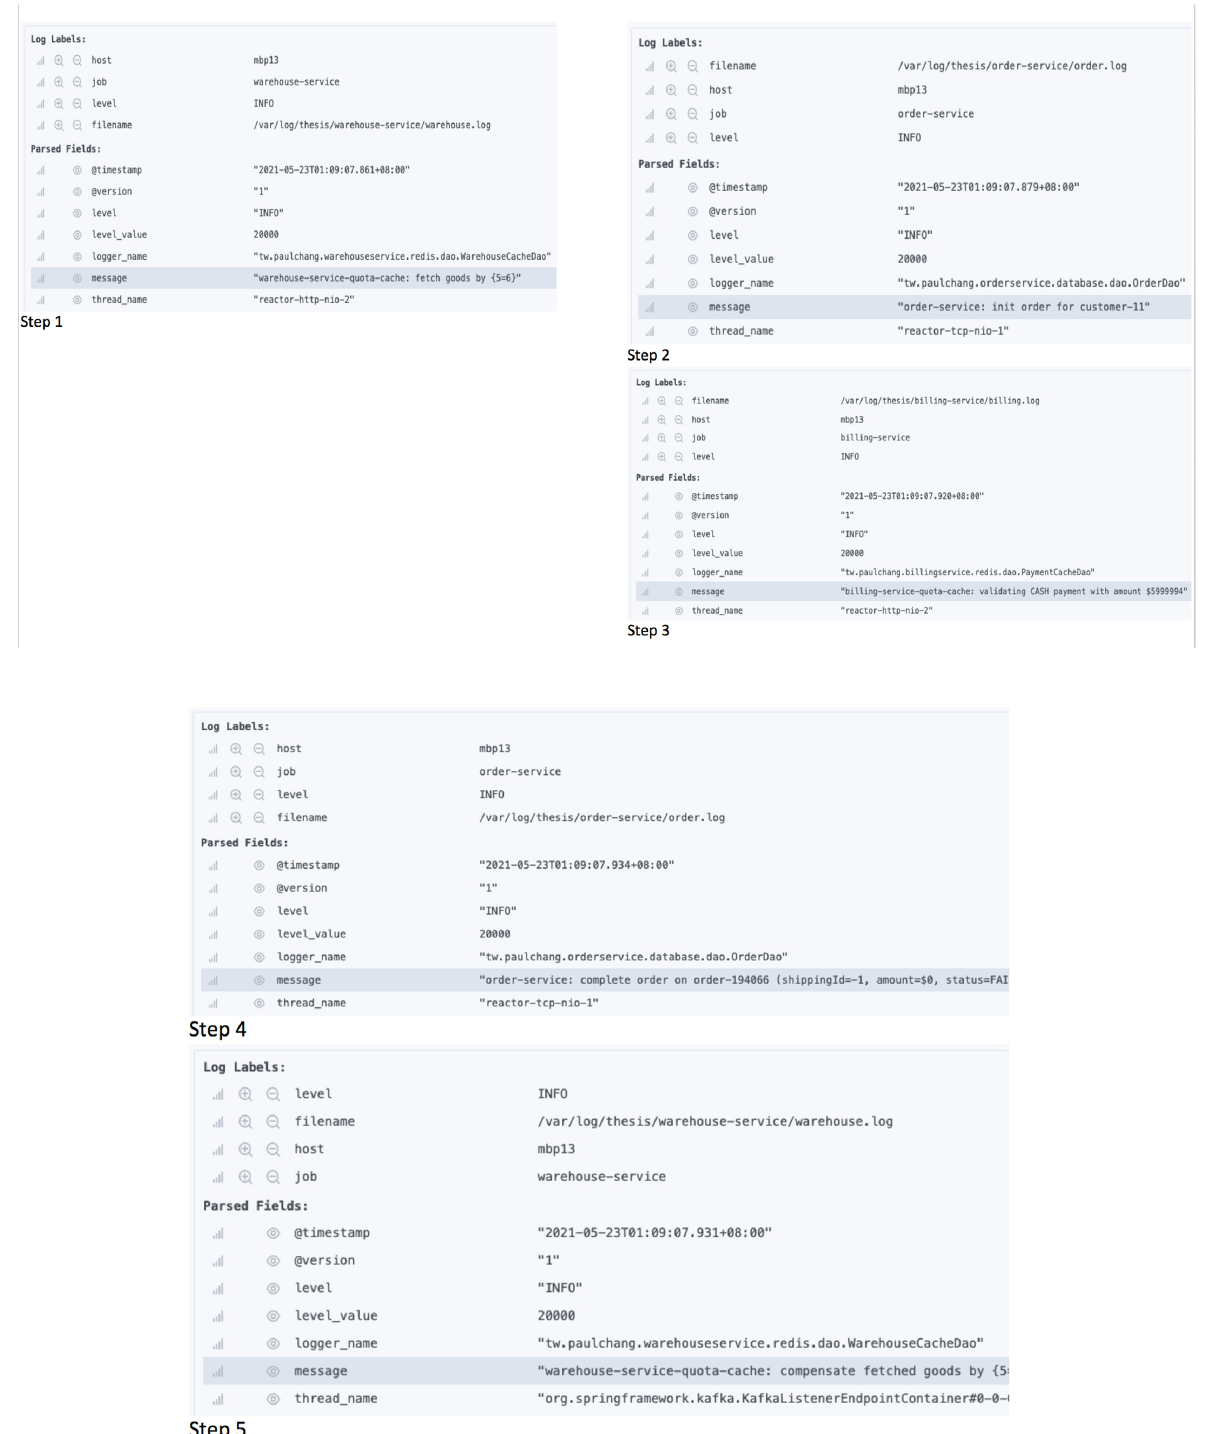
Figure 12. The Steps performed by version 2 (deploying enhanced saga pattern) when an exception has